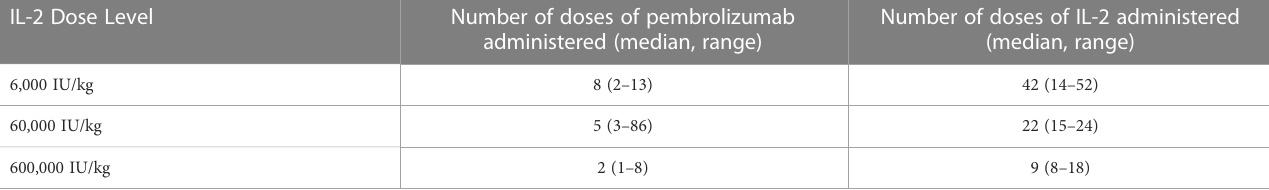
TABLE 2 Treatment administration.